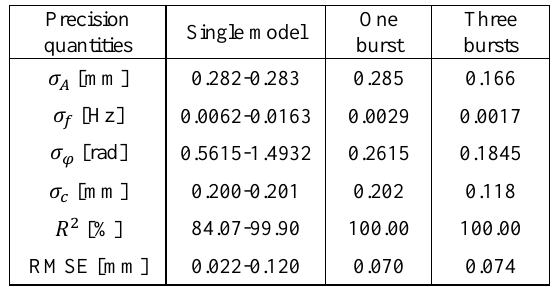
Table 2. Statistical values for the sinusoidal fitting parameters estimated for 𝑋 (1 Hz)